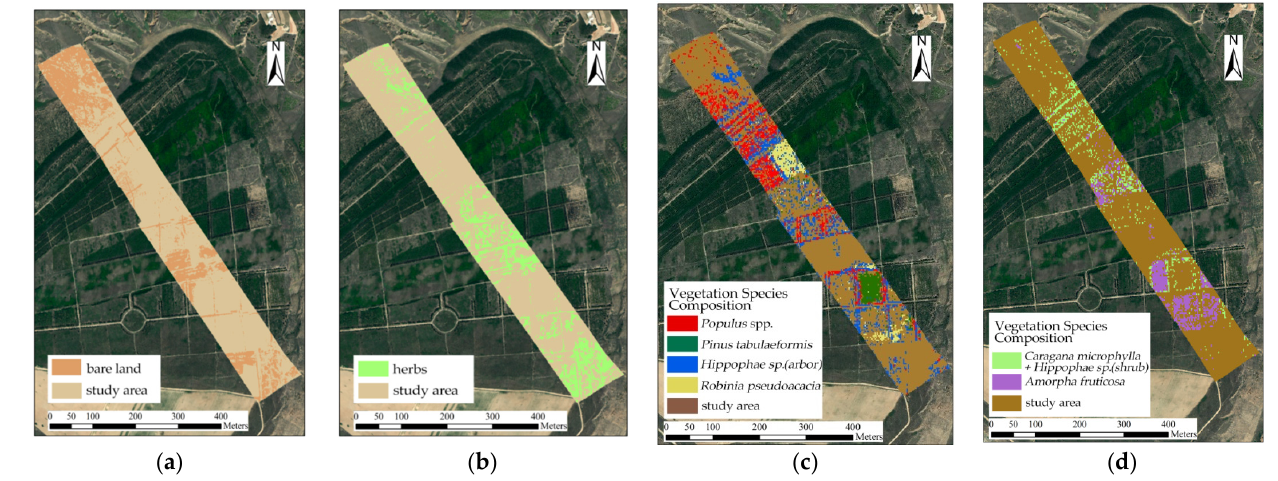
Figure 17. Classification results: ( a ) the first layer of bare land; ( b ) the second layer of herbs; ( c ) the third layer of trees— Populus spp., Pinus tabuliformis , Hippophae sp. (arbor), and Robinia pseudoacacia ; ( d ) the fourth layer of shrubs— Caragana microphylla + Hippophae sp. (shrub) and Amorpha fruticosa .